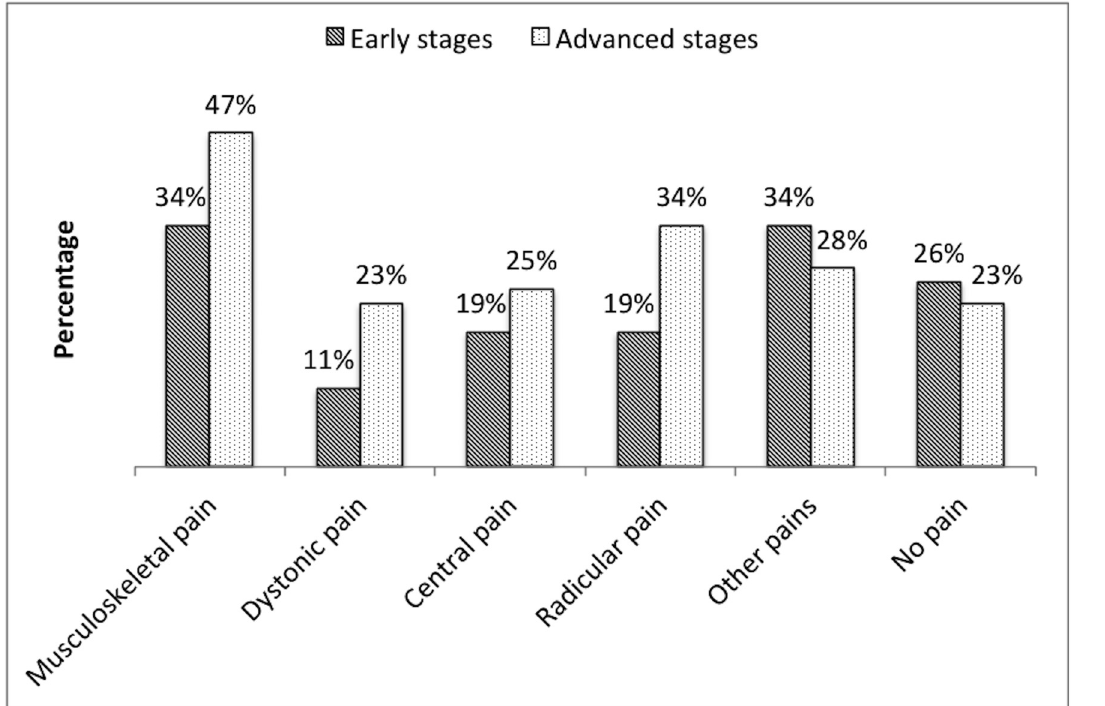
Fig 1. Distribution of pain types in PD patients. Note the higher prevalence of all types of pain except for “ other pain ” in the advanced stage of PD.